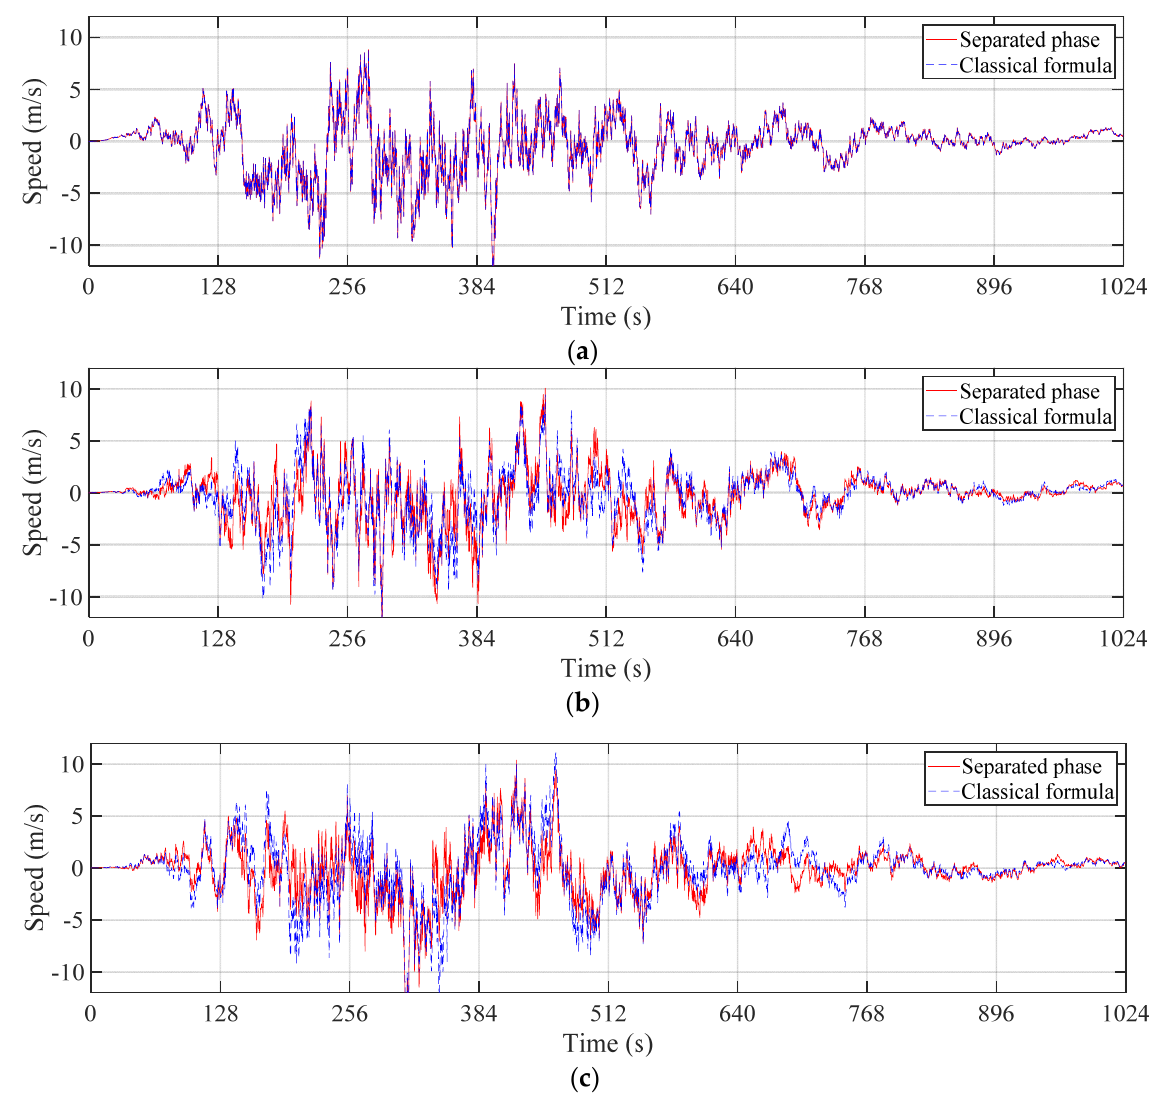
Figure 7. Simulated time-invariant coherent nonstationary wind fluctuation samples: ( a ) Point 1; ( b ) Point 21; ( c ) Point 41.